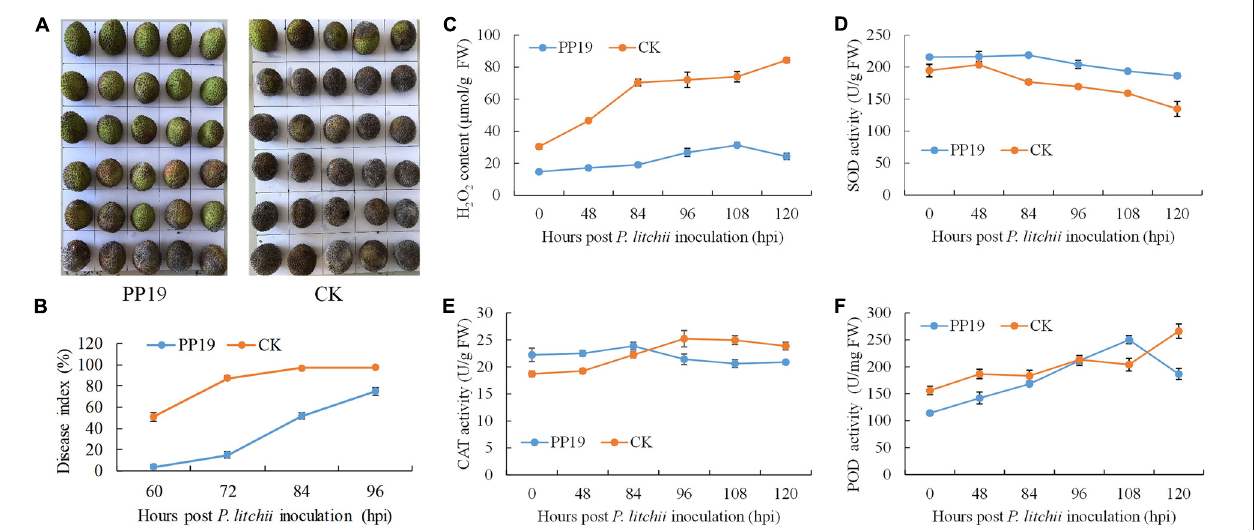
FIGURE 3 | Suppression of LDB and enhancement of defense-related enzyme activity by preharvest treatment with PP19. (A) Visual comparison between PP19 preharvest treatment and control groups at 72 hpi. (B) LDB disease index for fruit treated with PP19 solution at preharvest and those treated with the control LB media. (C–F) Comparison of the H 2 O 2 contents and SOD, CAT and POD activities detected after P. litchii inoculation in the PP19 preharvest treatment and control